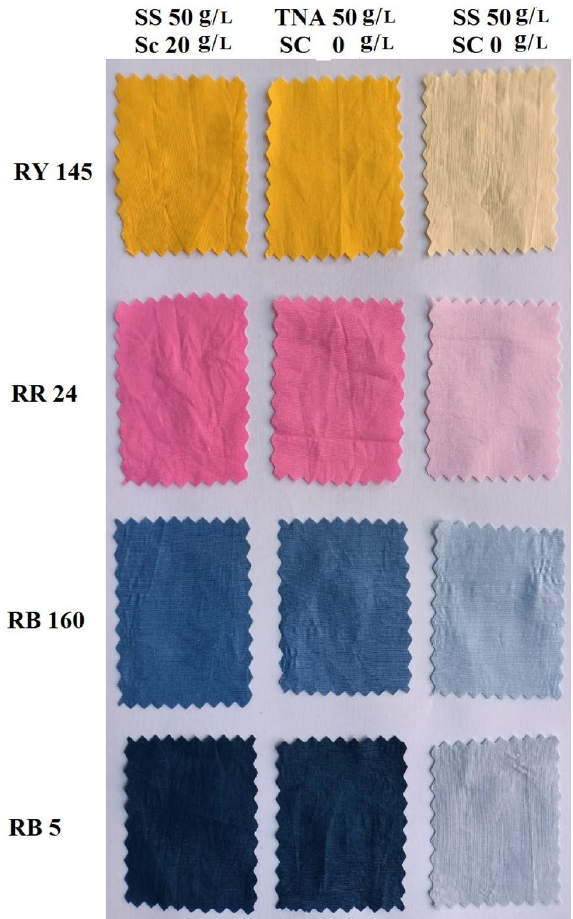
Figure 12. Images of the dyed cotton fabrics of different dyes using the conventional method (SS 50 g/L, SC 20 g/L compared with 50 g/L TNA methodand the dyed sample using global salt 50 g/L with 0 g/L of sodium carbonate for 2% owf, LR